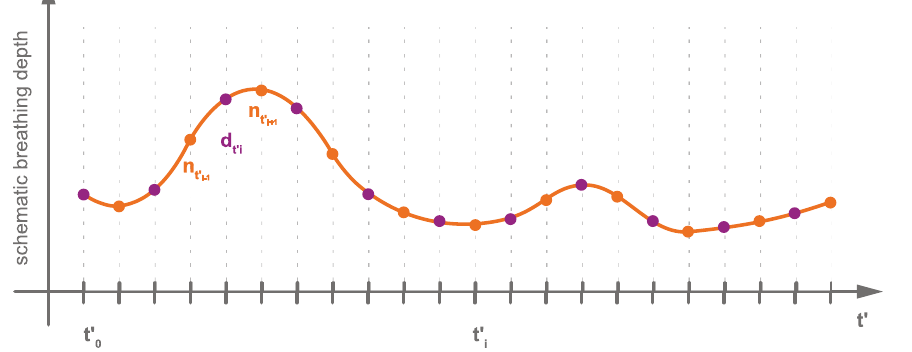
Fig 2. Schematic depiction of an interleaved sequence. An interleaved sequence consists of navigator frames and data frames that were imaged alternatingly. It shows a different breathing curve than the navigator sequence but contains similar breathing